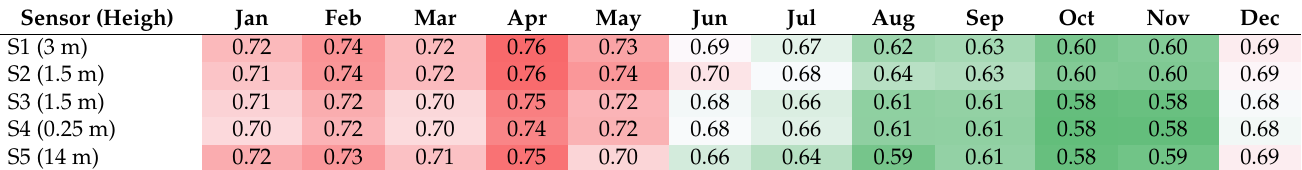
Table 9. Risk index of condensation inside the building.